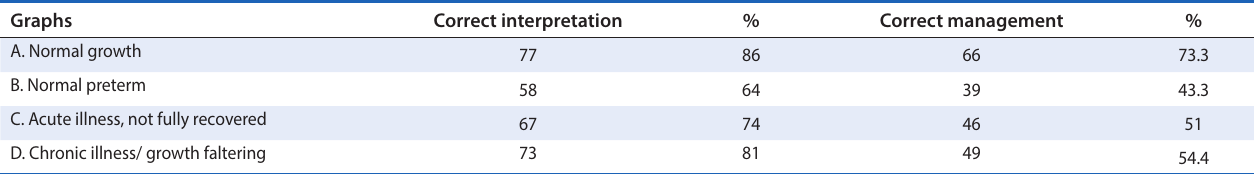
Table 2: Interpretation and management according to ‘Road to Health’ chart graph Graphs